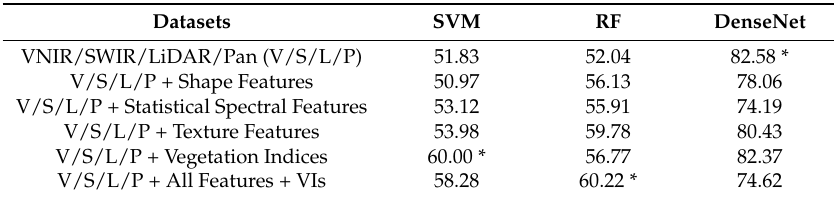
Table 8. Overall accuracies for SVM, RF, and DenseNet classifiers using fused imagery dataset combined with different segmented feature types or vegetation